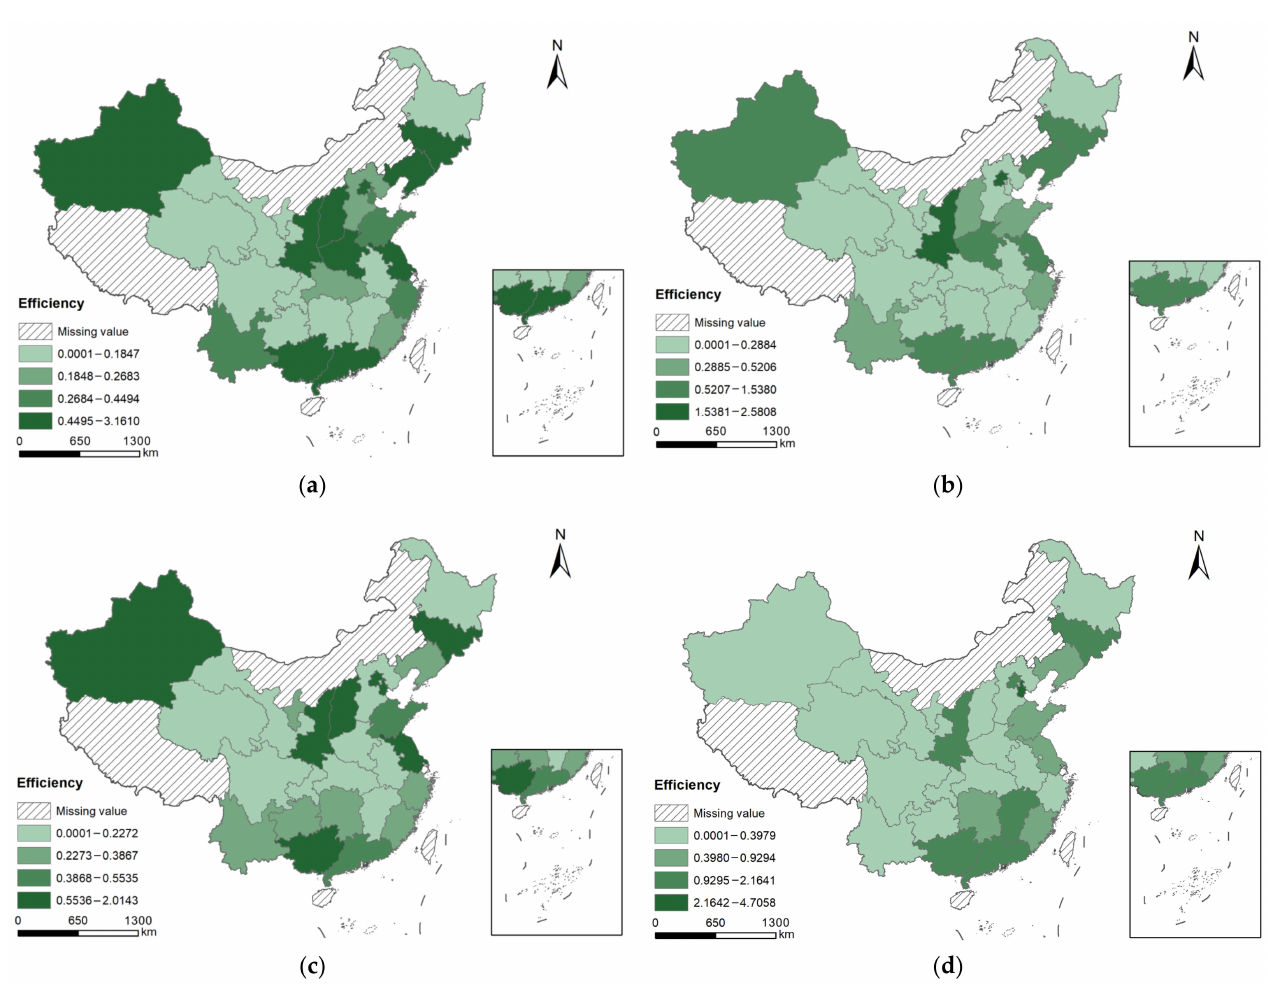
Figure A1. Evolution trend of NSAs’ tourism efficiency in China from 2003 to 2017. ( a ) 2003; ( b ) 2008; ( c ) 2013; ( d )